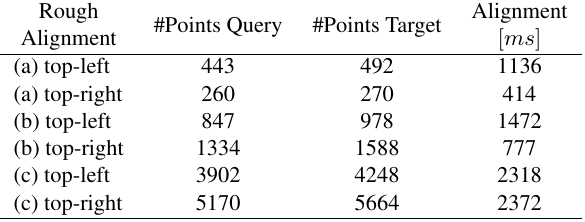
Table 3: Performance After Post Filtering